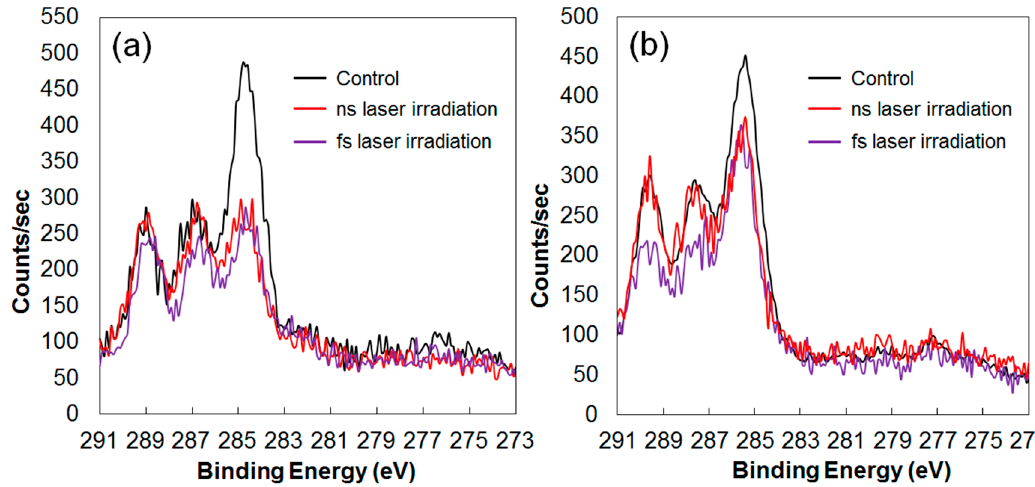
Figure 1. C1s narrow scan XPS spectra for the surface of PLGA films ( a ) and PLLA films ( b ). Black, red, and purple lines indicate non-irradiated films (control), films irradiated with a nanosecond laser, and films irradiated with a femtosecond laser, respectively. A wavelength of 266 nm was used for both cases with femtosecond laser pulses and nanosecond laser pulses.